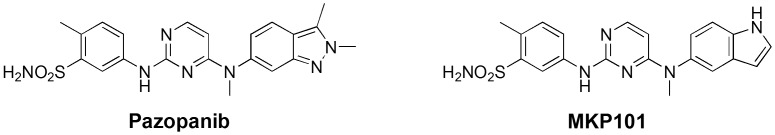
Structure of pazopanib and its indole derivative MKP101.